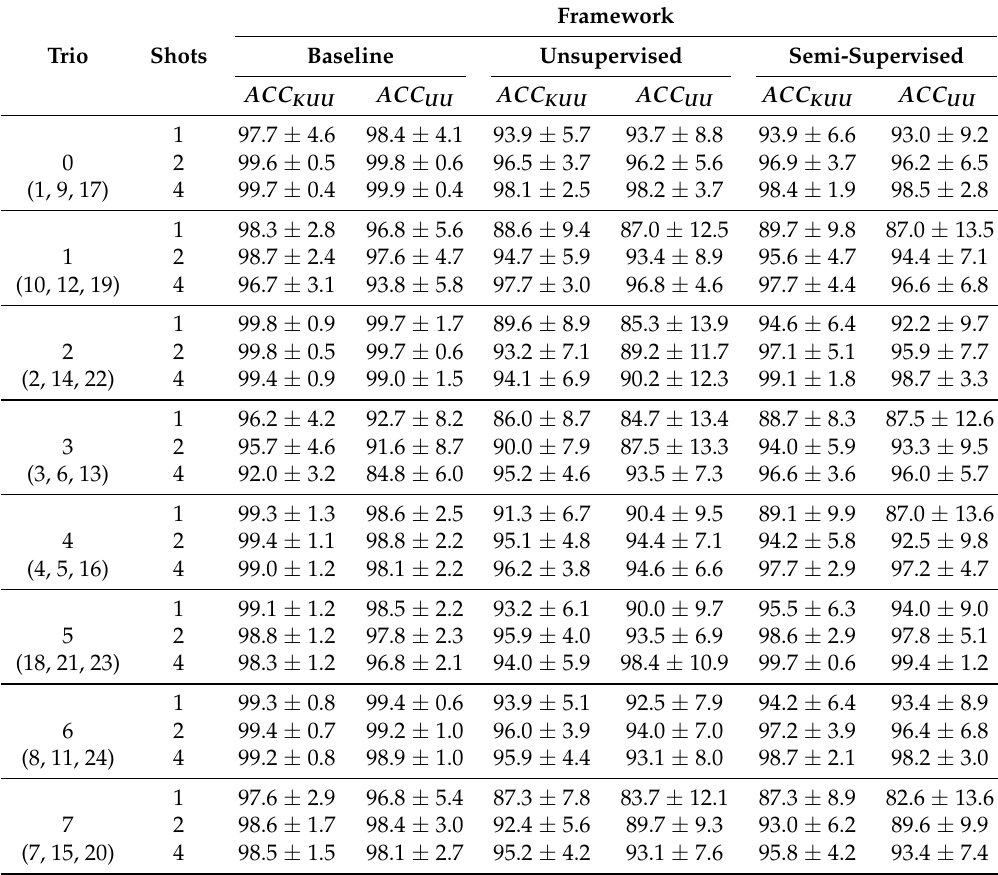
Table 6. Results of unwanted category with trios configuration and O ∗ = 0.13. The number list under the trio number corresponds to the number of patterns that make up that trio.